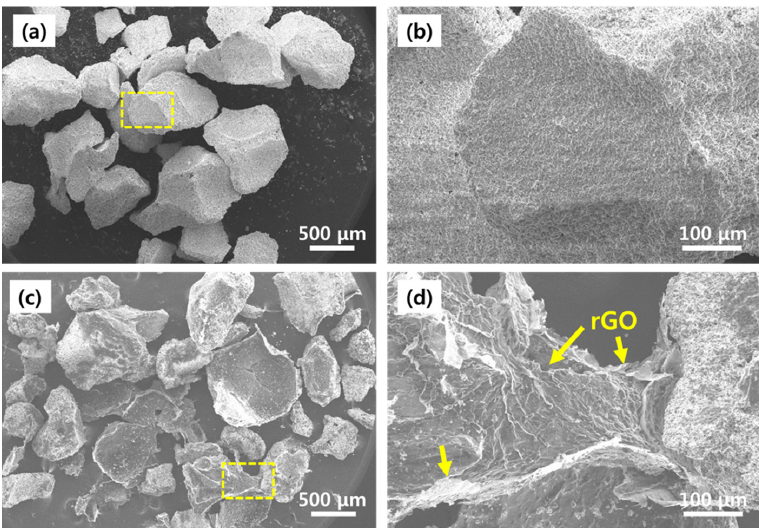
Figure 2. Representative scanning electron microscopy (SEM) images of DCP microparticles and DCP5 ‐ rGO10 hybrid composites. ( a ) Low ‐ magnification and ( b ) higher ‐ magnification images of DCP microparticles; ( c ) Low ‐ magnification and ( d ) higher ‐ magnification images of DCP ‐ rGO hybrid composites. Yellow arrows indicate the reduced graphene oxide (rGO). The dashed yellow squares denote the region shown in ( b , d ).